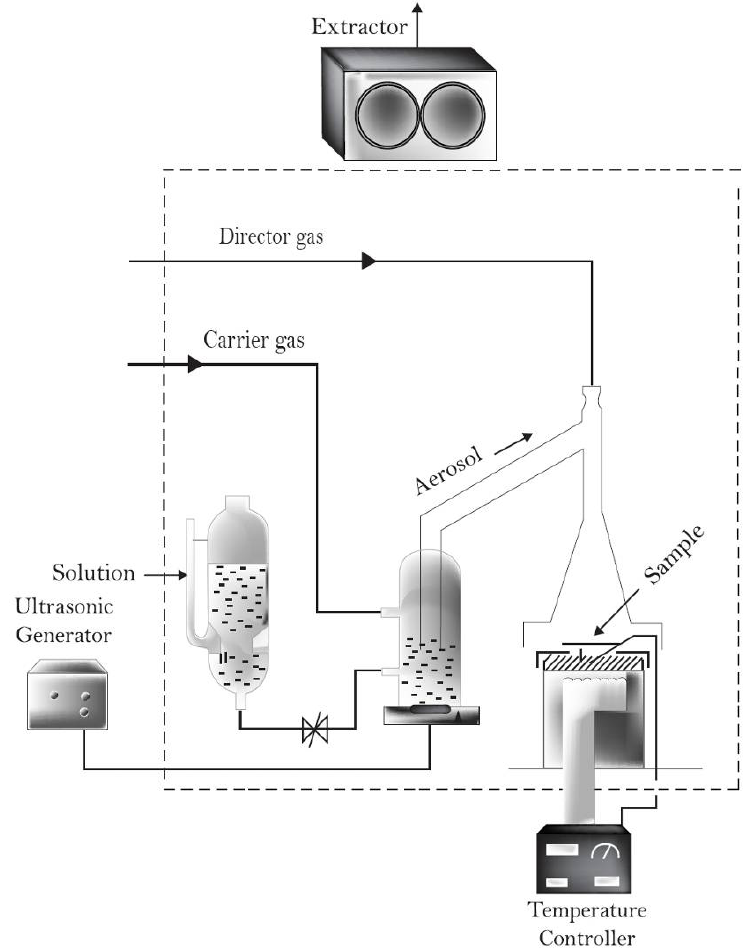
Figure 1. Schematic diagram of the experimental set up used for depositing the ZnO:In thin films (ultrasonic spray pyrolysis: